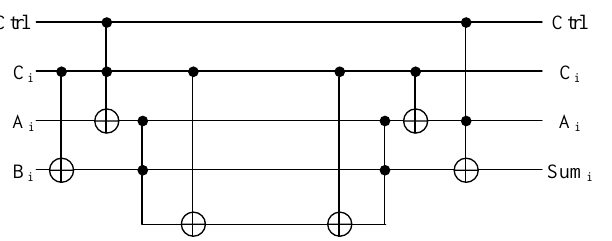
Figure 5. Quantum controlled addition circuit with T-count = 18 and T-depth = 8 [10].